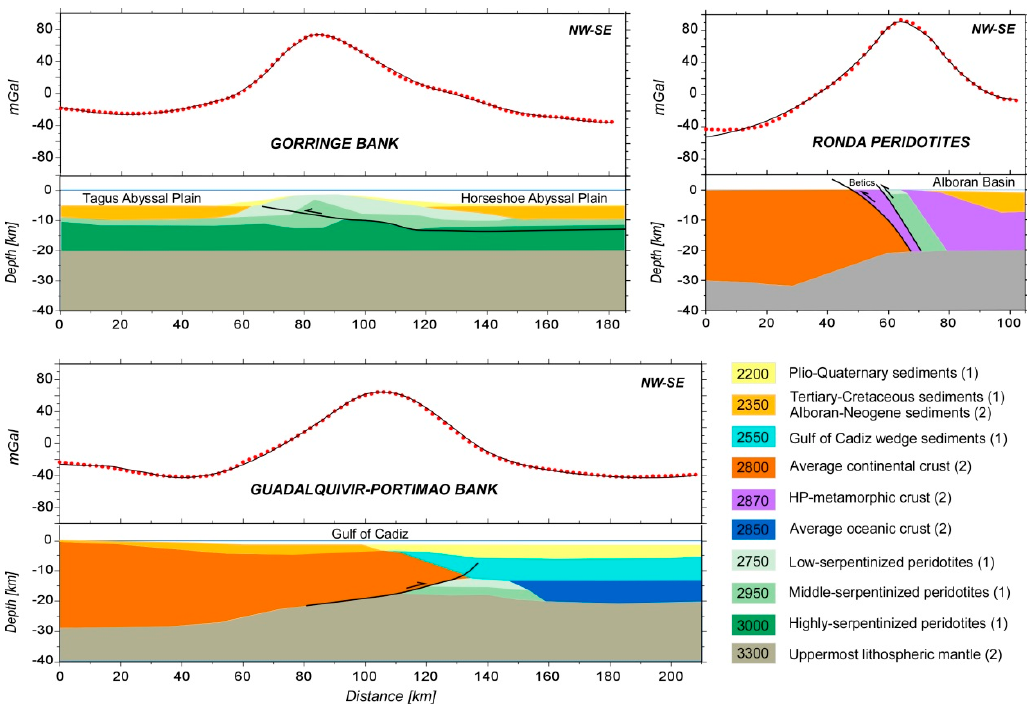
Figure 4. Gravity modelling of filtered Bouguer anomaly of simplified crustal cross sections across the Gorringe Bank, the Guadalquivir–Portimao Bank, and the Ronda Peridotite Massif (see locations in Figure 3). The legend indicates the adopted lithologies and density values (kg / m 3 ) from the work of [23] (1) and this study (2). HP, high pressure.